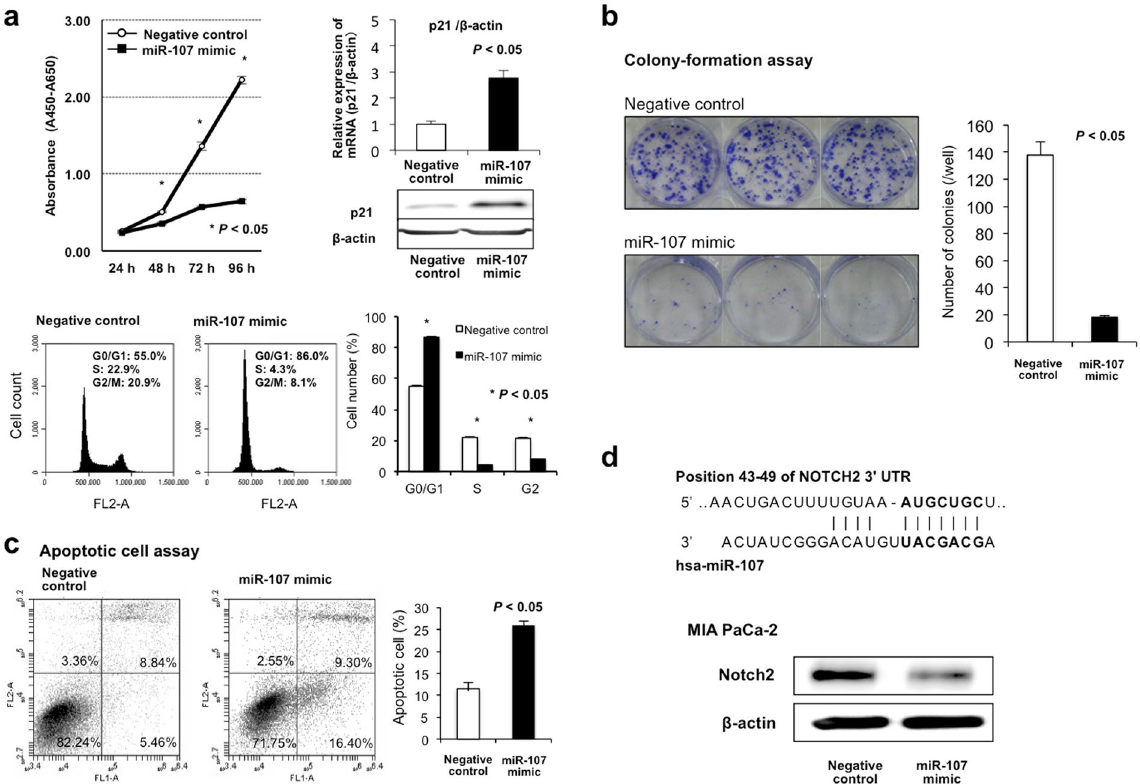
Figure 4. Investigation of the tumor suppressor function of miR-107 in PCa cells. ( a ) Cell proliferation analysis by miR-107 overexpression. Proliferation was significantly suppressed in MIA PaCa-2 cells transfected with the miR-107 mimic compared with cells transfected with the negative control mimic. The FACS analysis demonstrated that transfecting MIA PaCa-2 cells with the miR-107 mimic resulted in an accumulation of cells in the G0–G1 phase compared with transfection with the control miRNA mimic. In MIA PaCa-2 cells, p21 mRNA and protein levels were increased at 72 h after transfecting the cells with the miR-107 mimic. These findings indicated that miR-107 overexpression in PCa cells induced the production of p21, which results mainly in G0–G1 arrest. ( b ) miR-107 overexpression inhibits colony formation. Colony-formation assays were performed using MIA PaCa-2 cells. PCa cells were transiently transfected with the miR-107 or control mimic for two weeks. The number of colonies in MIA PaCa-2 cells treated with the miR-107 mimic was significantly lower than that in MIA PaCa-2 cells treated with the control mimic. ( c ) miR-107 overexpression induces cell apoptosis. The apoptotic cell analysis showed that miR-107 overexpression increased early apoptosis (annexin V-positive/PI-negative) and late apoptosis (annexin V/PI-double positive) 72 h after miR-107 mimic transfection compared with control mimic transfection in MIA PaCa-2 cells. ( d ) Notch2 as a novel target oncogene of miR-107 in PCa cells. An in silico search (http://www.targetscan.org/) identified Notch2 as a novel target oncogene of miR-107 in PCa. The seed regions of the miR-107 and complementary Notch2 3 ′ UTR sequences are presented in this figure. miR-107 overexpression inhibited Notch2 protein production. Error bars indicate standard error of the mean (s.e.m.); n = 4 technical replicates of a representative experiment (out of four